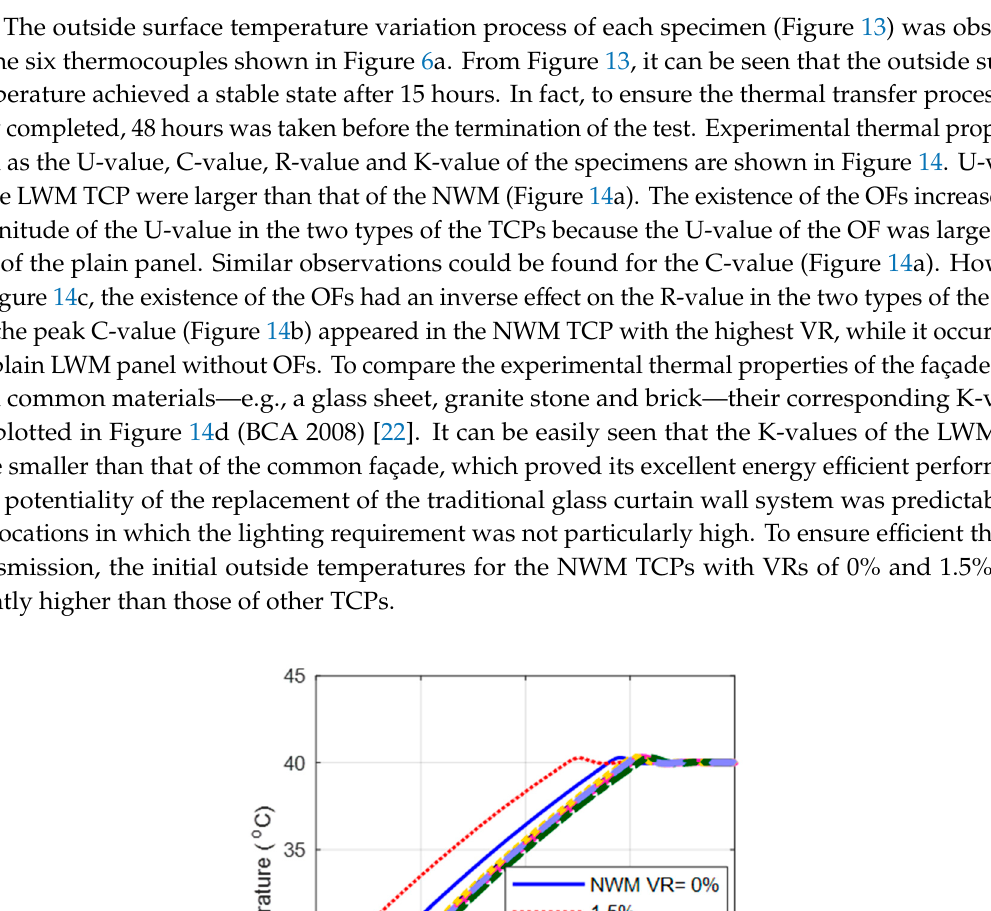
( d ) Figure 14. Thermal properties: ( a ) U-value; ( b ) C-value; ( c ) R-value; ( d ) K-value. 4.2. SHGCs In the tests, the solar irradiance was about 510.0 W/m 2 , the air temperature in the CHB was 24 °C and the temperature was 23–32 °C outside of the CHB. The airflow velocity was 0.26 m/s in the CHB, and 2.5 m/s outside of the CHB; both moved vertically upward. The experimental SHGC values of the two TCPs are listed in Table 4; these were 0.198 and 0.242 for the LWM and NWM TCPs,